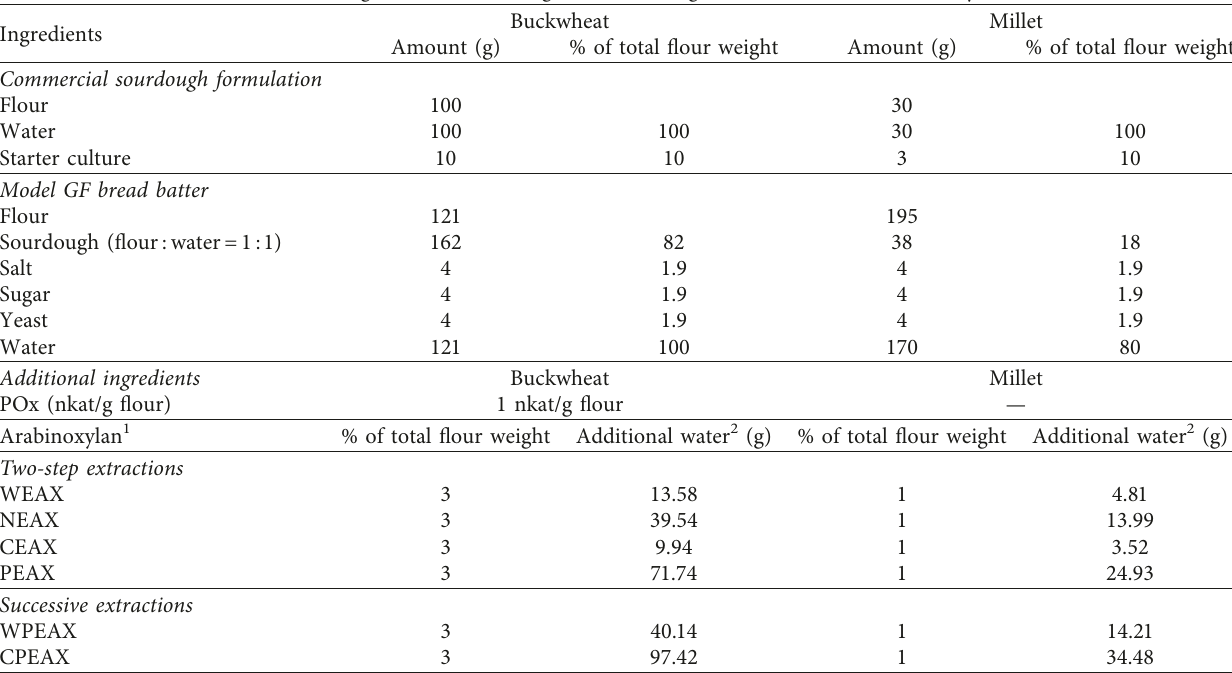
Table 2: Formulation of gluten-free sourdough and sourdough-bread added with arabinoxylans and POx.